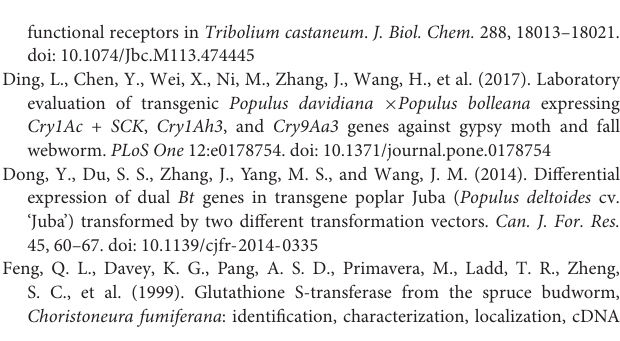
Supplementary Figure 1 | Comparison of insect experiments. (A) H. cunea L1 larvae. (B) P. versicolora L1 larvae. (C) P. versicolora L2 larvae. (D) P. versicolora